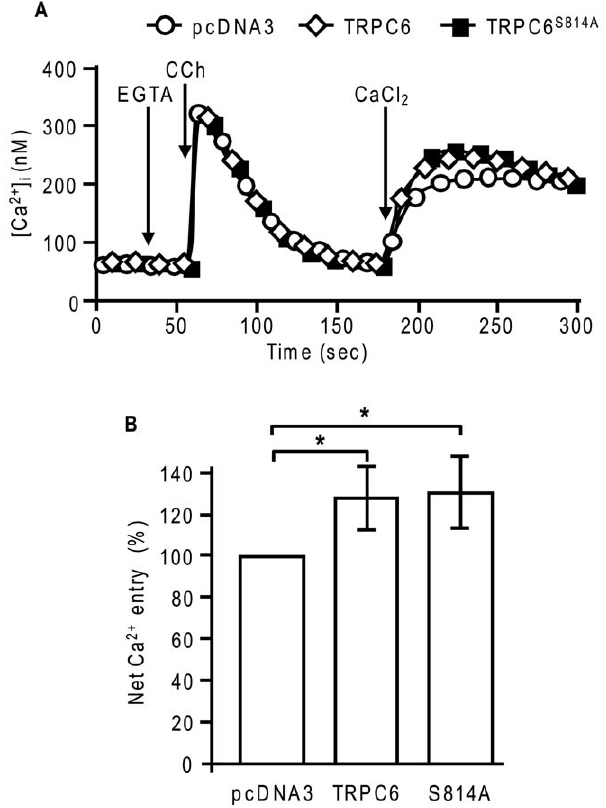
Figure 3. The S814A mutation does not alter TRPC6 activity. A , [Ca 2 + ] i was recorded in HEK293T transiently transfected with pcDNA3 (open circles), TRPC6WT (open diamonds), or TRPC6 S814A (closed squares). The cells were incubated in the absence of extracellular Ca 2 + (in the presence of 0.5 mM EGTA) for 30 s before being stimulated with 5 m M CCh. External Ca 2 + (1.8 mM) was restored at 180 s. The graphs represent the average of 103 to 165 cells from one representative experiment. B , CCh-induced net Ca 2 + entry (average of [Ca 2 + ] i values after 174–177 s subtracted from [Ca 2 + ] i values after 222– 228 s) were calculated and graphed as averages 6 SD of six independent experiments. * P , 0.01 .